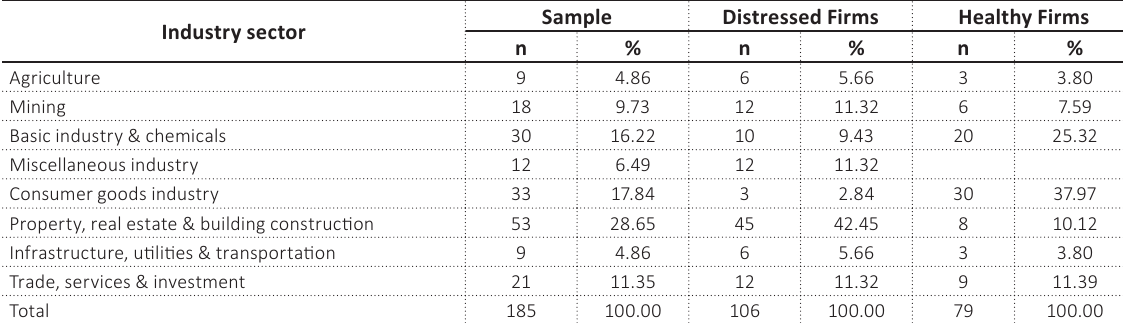
Table 1. Sample by the IDX industry sector and financially healthy versus distressed firms Sample Distressed Industry sector